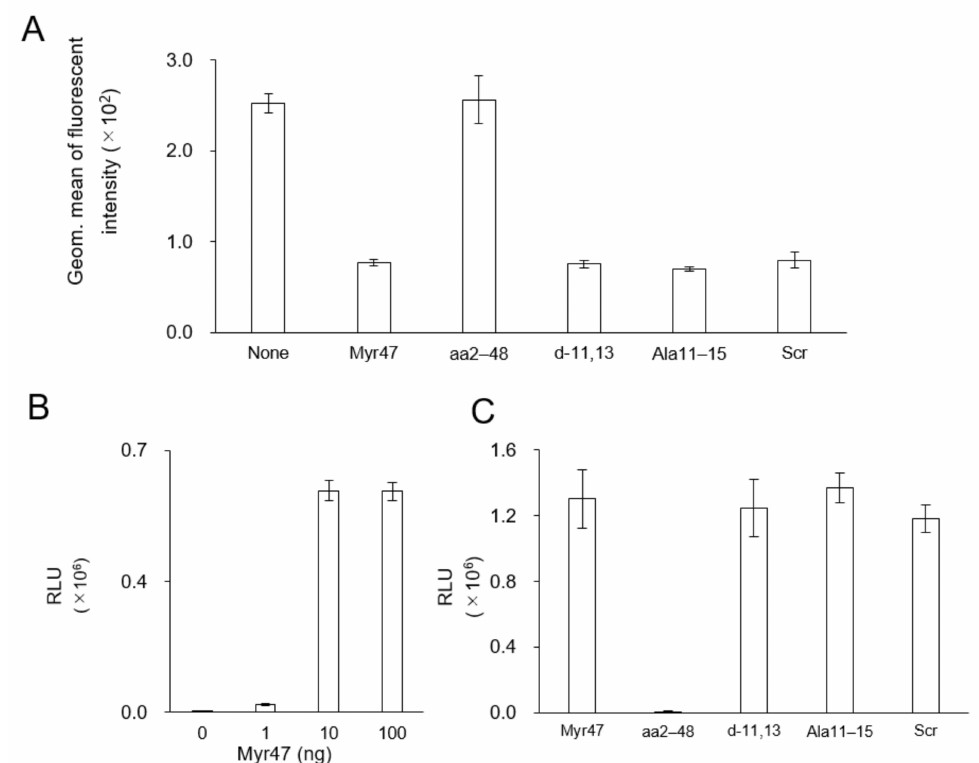
Figure 6. Effect of Myr47 and its mutants on the cellular HBsAg uptake activity and the in vitro direct interaction with HBsAg. ( A ) Hep G2 cells were incubated with CellVue-labeled HBsAg (5 µ g/mL as protein) in serum-free DMEM containing Myr47 or its mutants (500 nM) for 3 h at 37 ◦ C, and then analyzed with flow cytometry. ( B ) Interaction of Myr47 with HBsAg analyzed by AlphaScreen assay. ( C ) Interaction of Myr47 or its mutants with HBsAg analyzed by AlphaScreen assay. Data are shown as means. ( n =